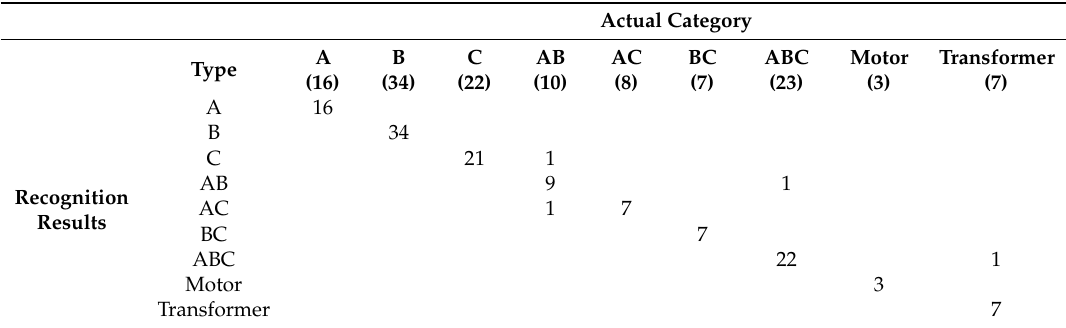
Table 4. Comparison of the recognition accuracy results between the DBN and support vector machine (SVM).